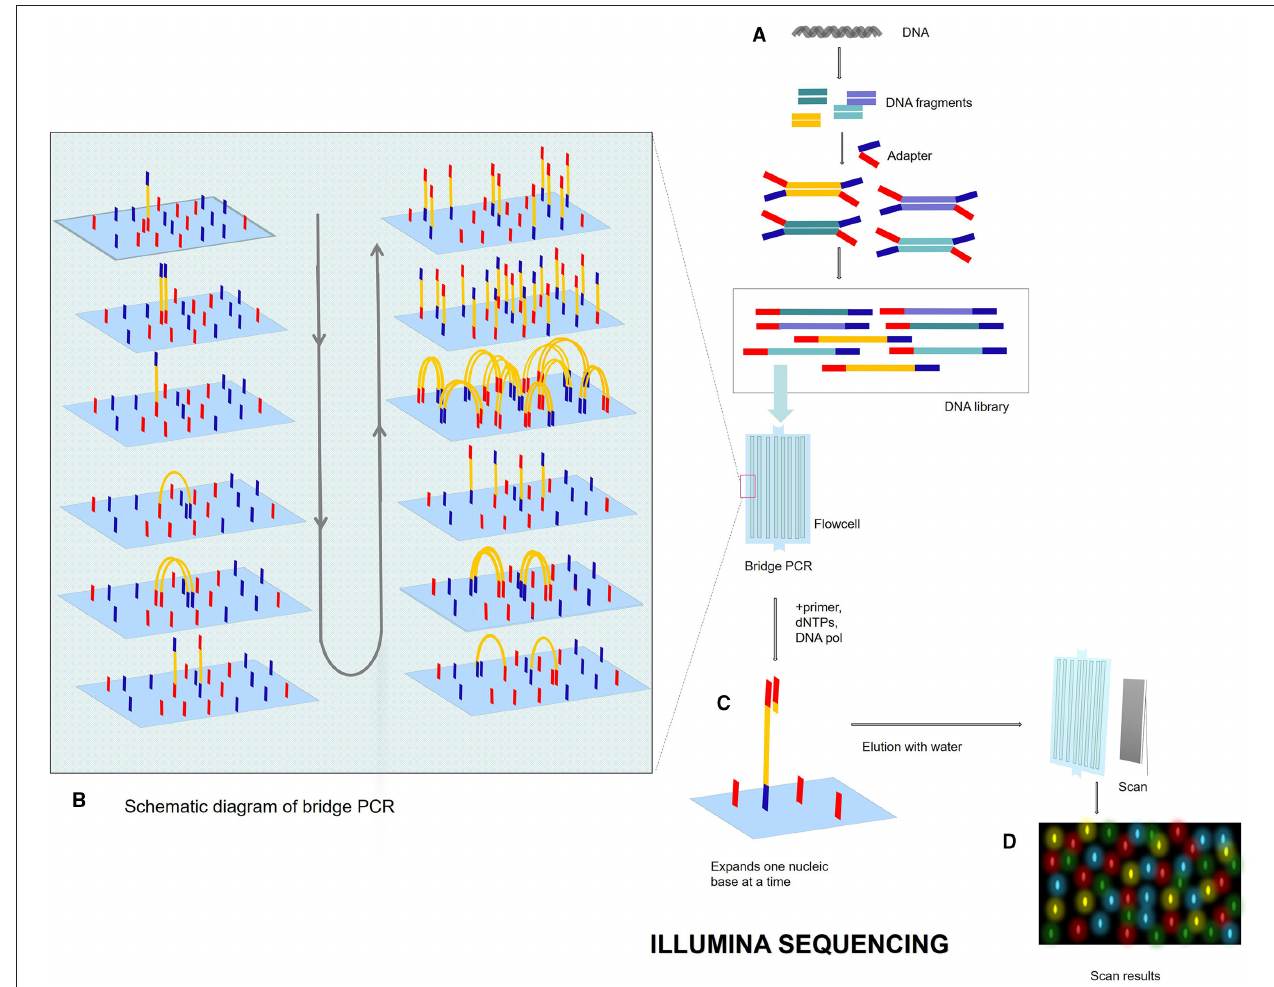
FIGURE 3 | Illumina sequencing process. (A) DNA library. Breaks the genome DNA to form DNA fragments, adds adapters at both ends, and constructs a single-stranded DNA (ssDNA) library. After adding DNA library into flowcell, DNA fragments will be attached to the surface of flowcell when passing through flowcell. (B) Bridge PCR. Each DNA fragment is clustered in its position. After bridge amplification, each cluster contains many copies of the ssDNA template. (C) SBS: DNA polymerase, primers, and four dNTPs with specific fluorescence are added to the reaction system at the same time. The 3 ′ end of these dNTPs is connected with an azide group, which can block the incorporation of the next base, so only one base can be extended at a time. After washing off the remaining dNTP and enzyme with water, photos are scanned. After scanning, add chemical reagent, cut off the azide group and quenching fluorescence, and next cycle. (D) Fluorescent signal